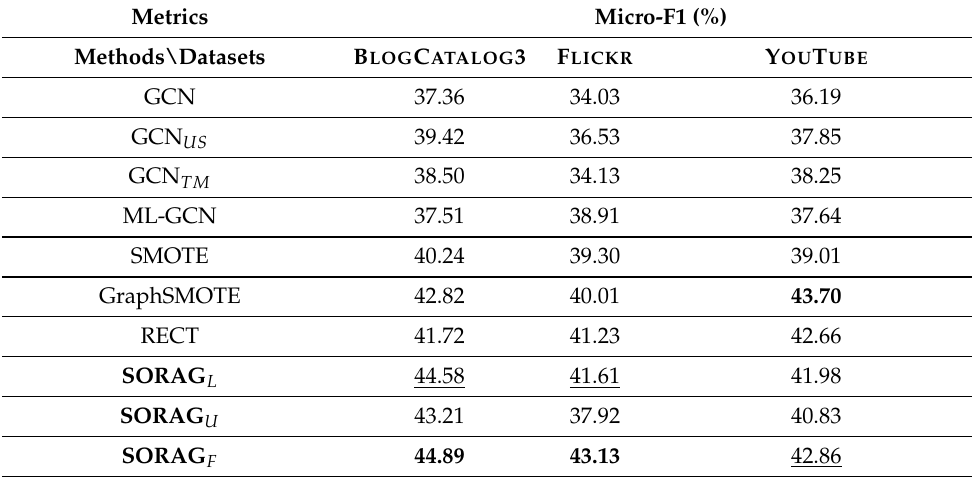
Table 2. Imbalanced multi-label classification comparison in terms of Micro-F1. The first and second best results are boldfaced and underscored, respectively.